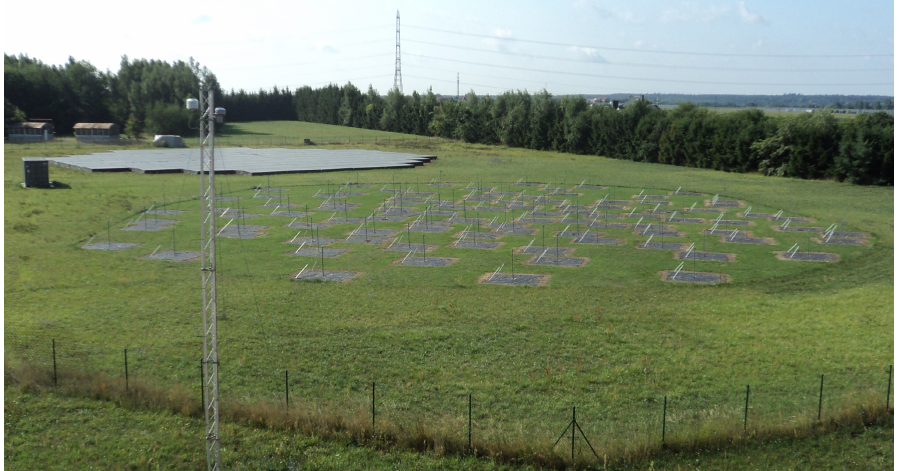
Figure 2. LOFAR PL610 station,